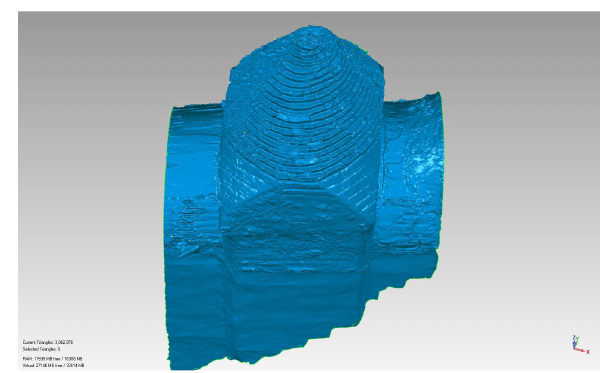
Figure 9-b. 50% filtered point cloud and medium smoothed mesh